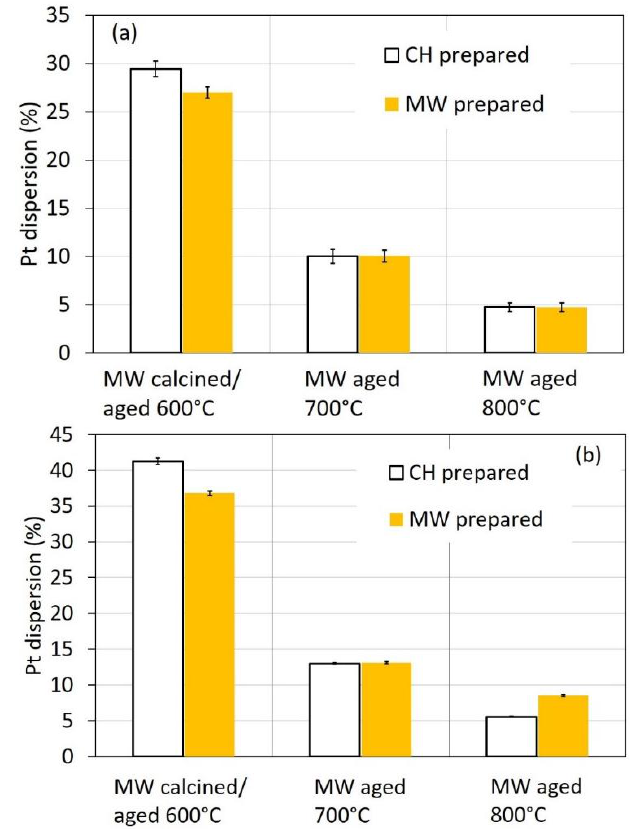
Figure 3. Platinum dispersion of various MW-aged Pt/Al 2 O 3 catalysts (30 min at 600 °C and 1 h at 700 and 800 °C). ( a ) CO chemisorption and ( b ) H 2 –O 2 titration results.